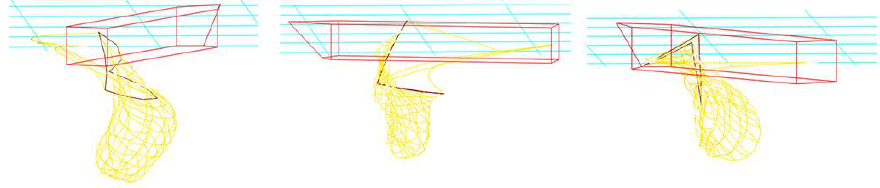
Figure 19. Shape changes at large angular velocity.